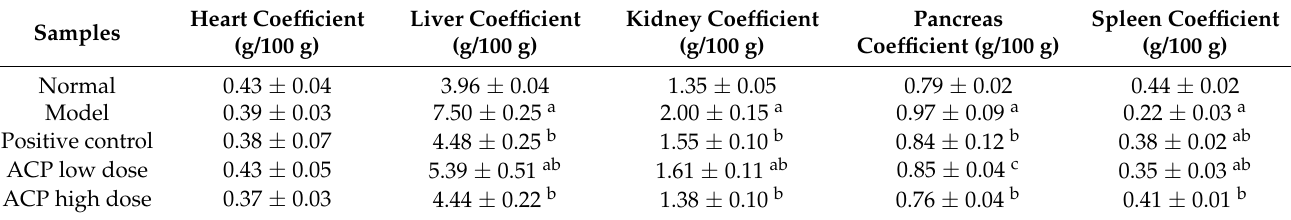
Table 5. Effects of ACP on the organ index in